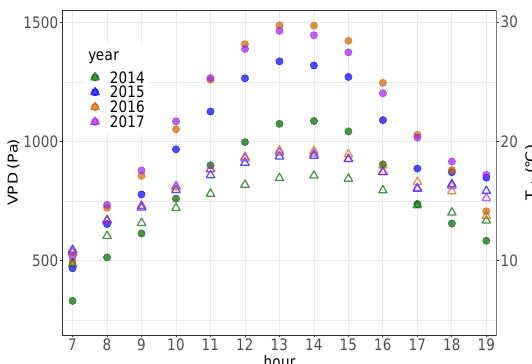
Figure 11. VPD (circles) and air temperature (triangles) during the daytime hours between 7:00 and 19:00 from 2014 to 2017 growing seasons.